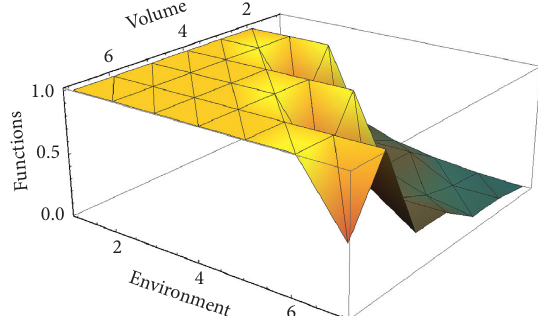
Figure 9: Fraction of the number of environment configurations that induce different functions as in Figure 7 for rule 90 (Class D). Note the repetitive